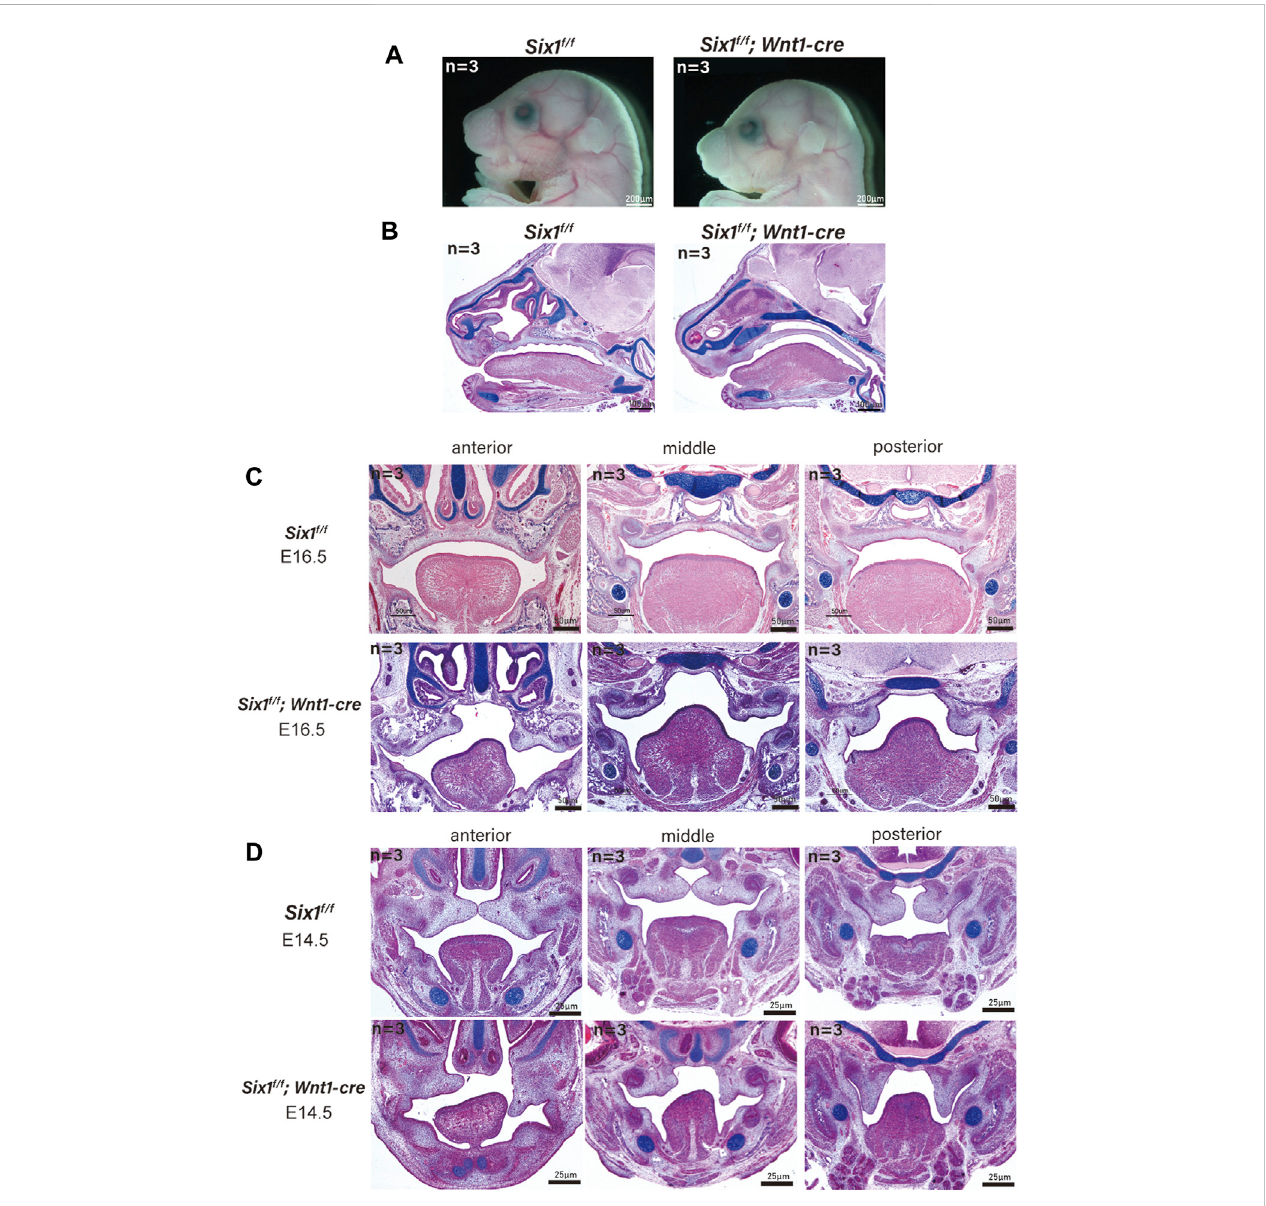
and Six1 f/f embryos . (B) HE and Alcian blue staining of sagittal sections showing the morphology of mandible of the Six1 f/f ; Wnt1-Cre and Six1 f/f embryos at E18.5. Six1 f/f ; Wnt1-Cre embryo shows a short mandible. (C, D) HE and Alcian blue staining of frontal sections of the Six1 f/f ; Wnt1-Cre and Six1 f/f embryos at E16.5 (C) and E14.5 (D) . Six1 f/f ; Wnt1-Cre embryo shows cleft palate at E16.5 and